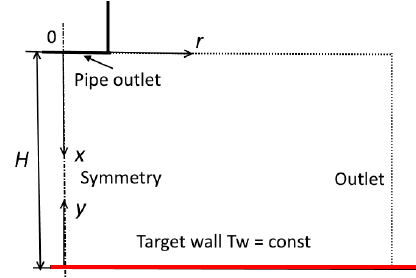
Figure 2. Computational domain with relevant boundary conditions.